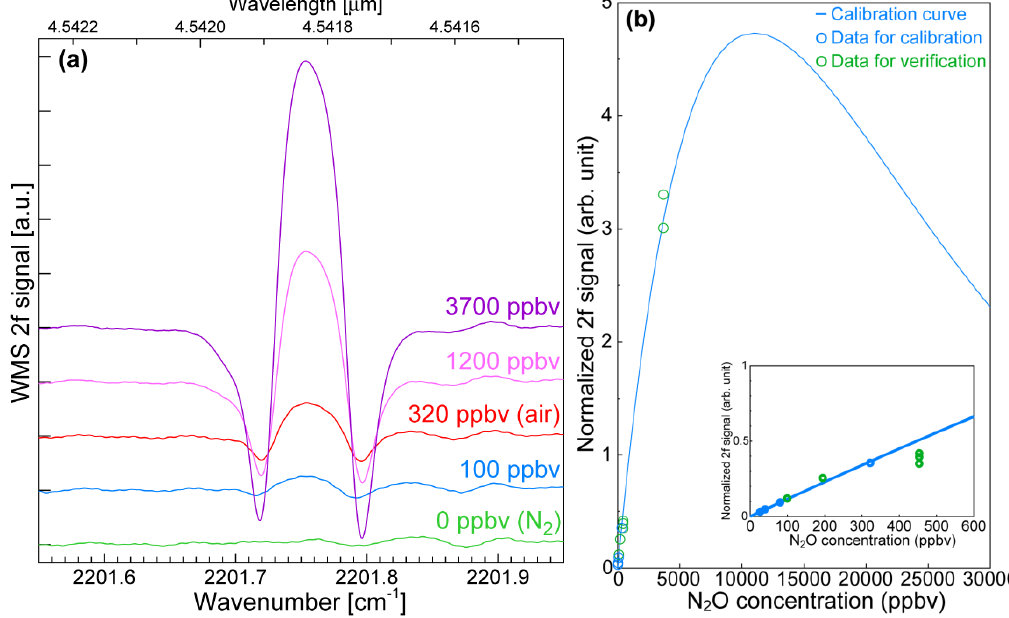
Figure 5. ( a ) WMS 2f spectra at various N concentration. The inset shows the same curve in the low concentration